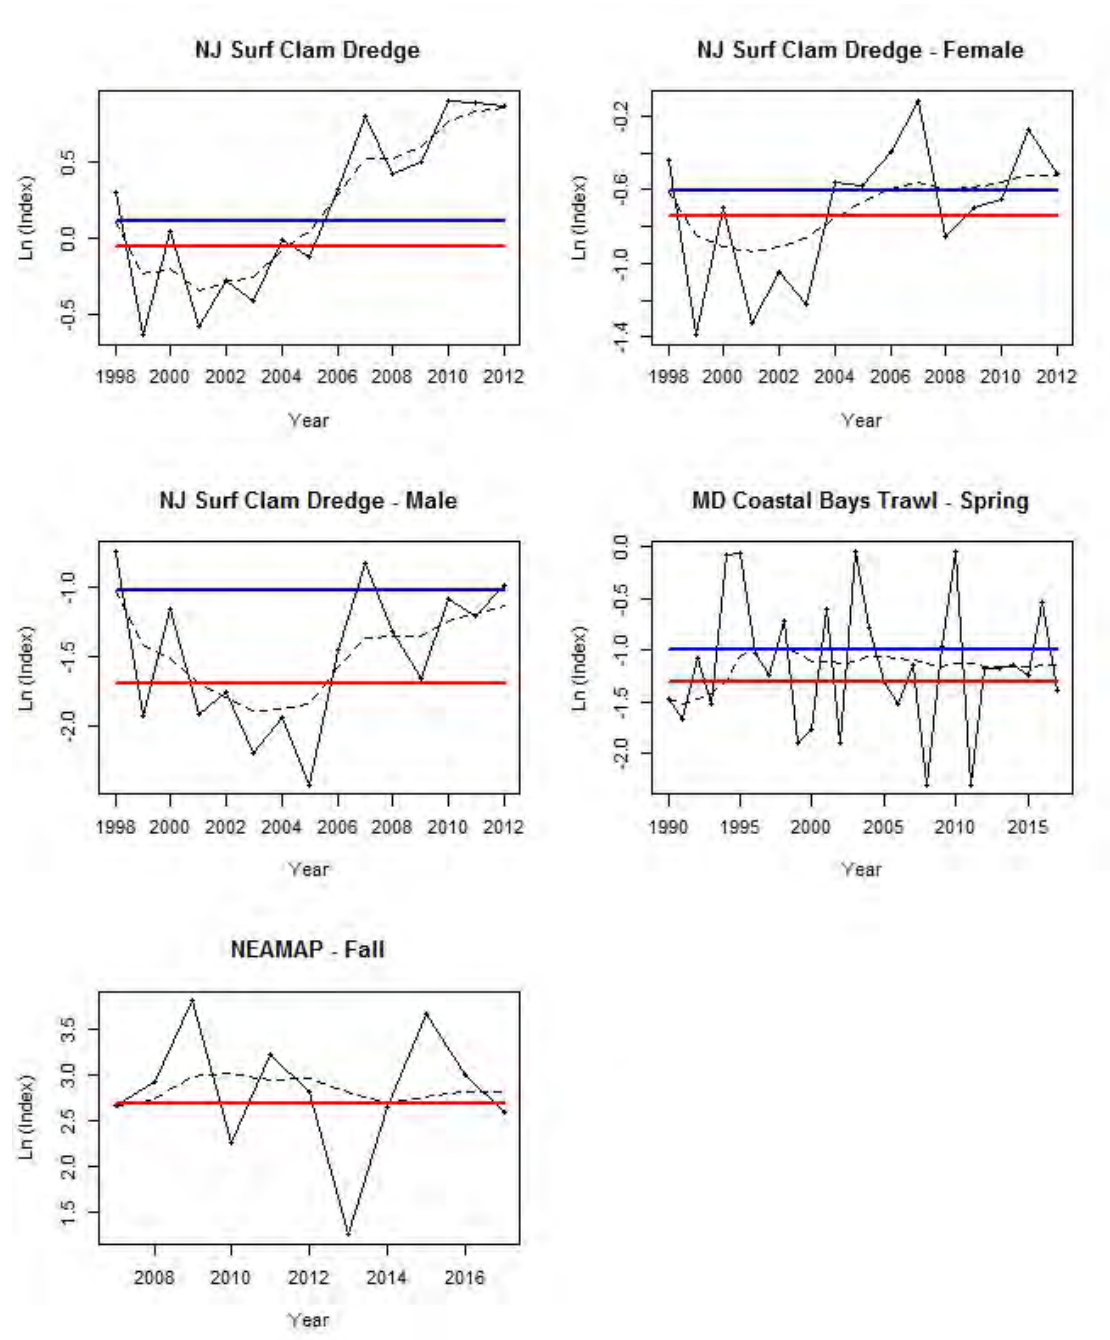
Figure 86. ARIMA model fits to horseshoe crab indices from various surveys in the Mid- Atlantic Region. The solid line represents the observed ln transformed indices and the dashed line represents the fitted indices. The red horizontal line represents the Q 25 reference point and the blue horizontal line represents the 1998 reference